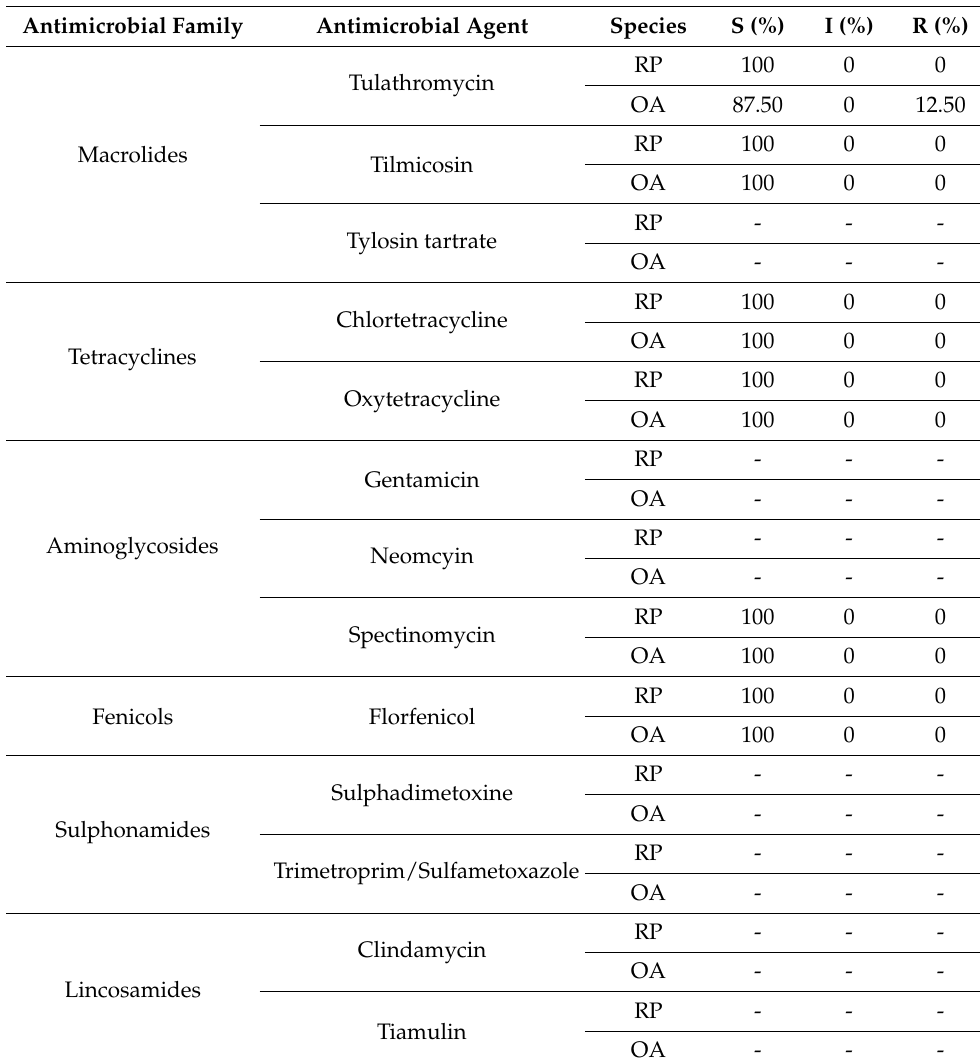
Table 3. Cont. M. haemolytica N = 14 (RP = 6, OA = 8) Antimicrobial Family Antimicrobial